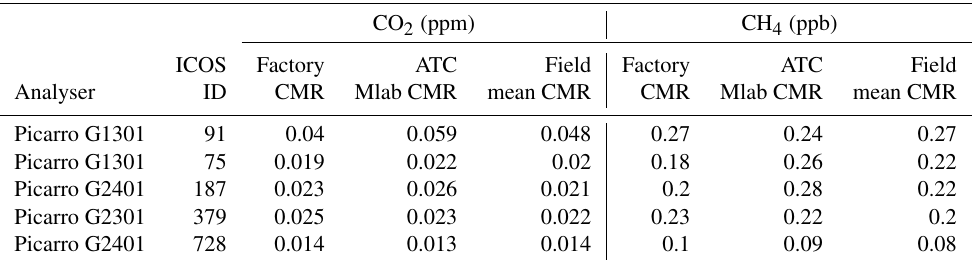
Table 5. Continuous measurement repeatability (CMR) and long-term repeatability (LTR)) between factory, MLab and field mean over 2011–2018 of CO (ppb). Their model and ICOS identifier are indicated in the first columns. CO (ppb) ICOS Factory ATC ATC